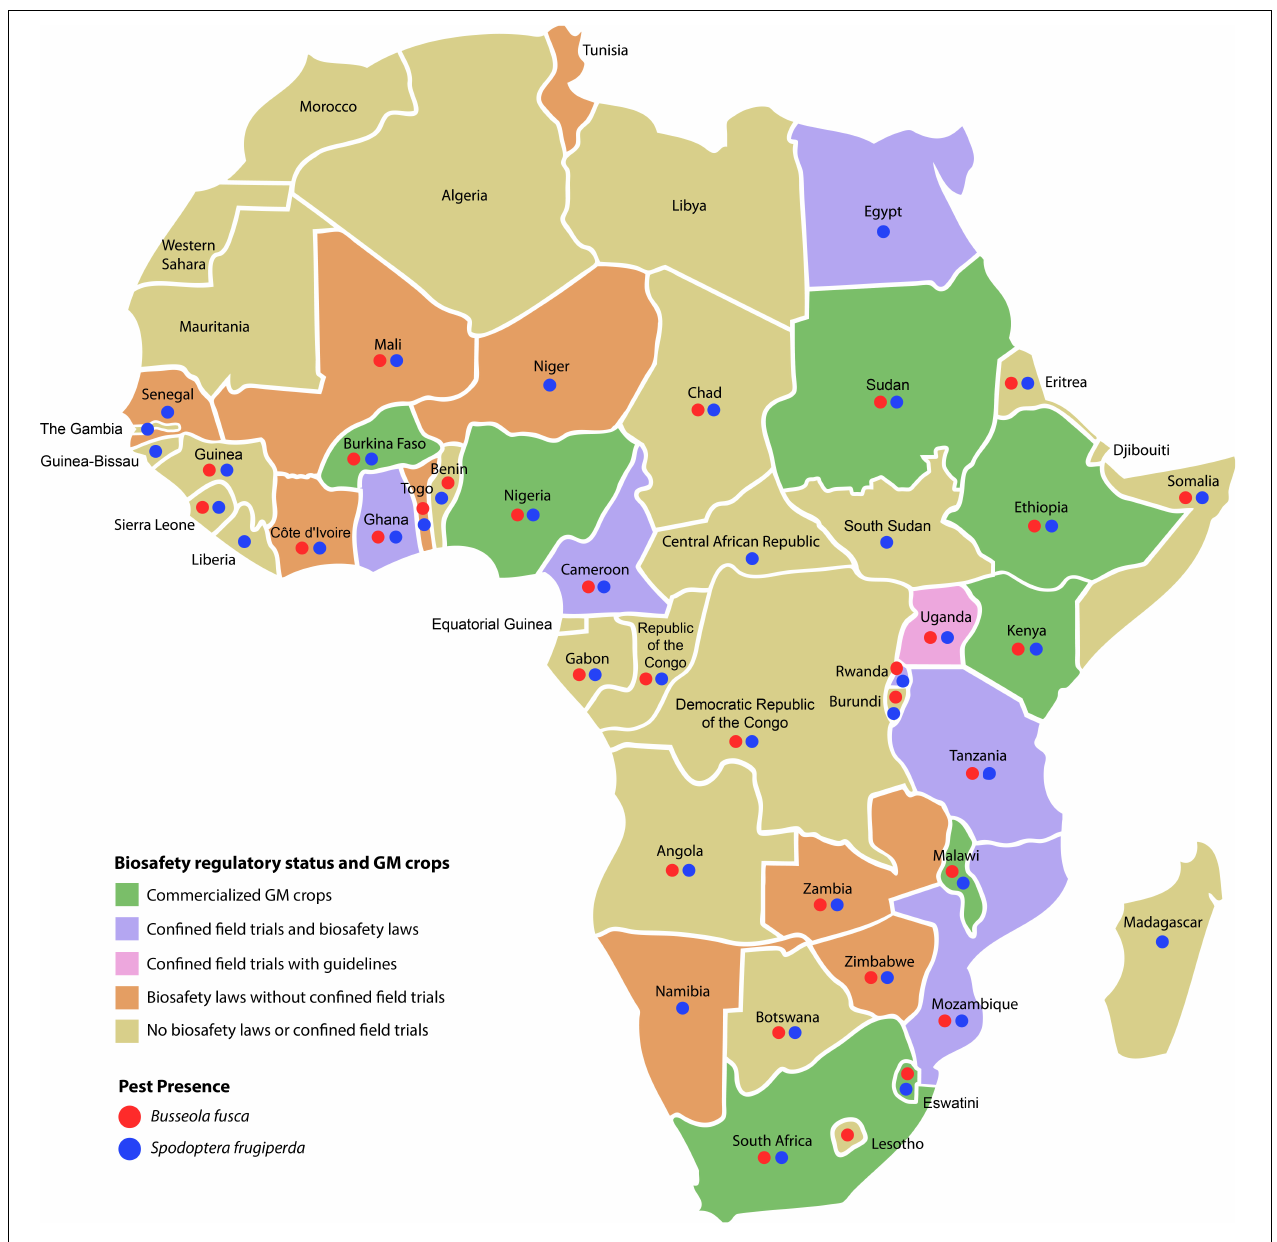
FIGURE 1 | Biosafety regulatory status and GM crops in Africa. Confined field trials refer to trials involving GM crops. The presence of key lepidopteran pests of maize, Busseola fusca and Spodoptera frugiperda , in each country is shown. Data sources for construction of the figure: Biosafety regulatory status and GM crops (ABNE, 2020); Pest presence (CABI,